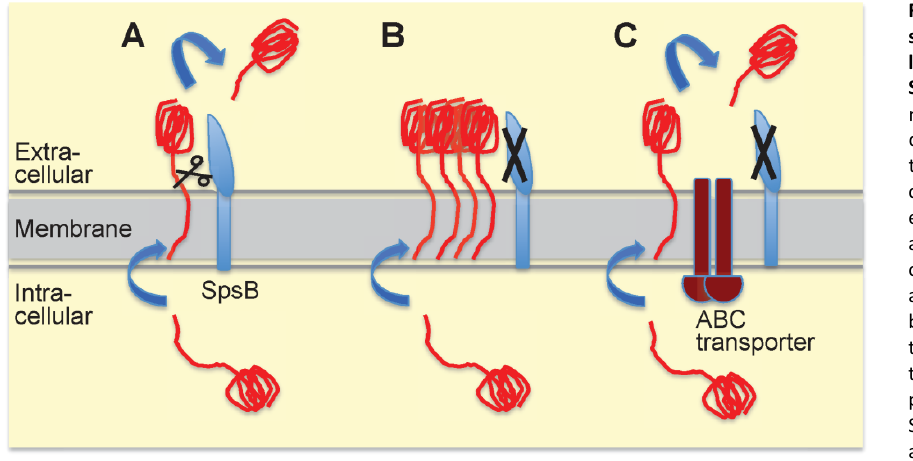
unprocessed proteins, and eventually resulting in cell death. (C) Over-expression of the putative ABC transporter (as in S. aureus with muta- tions in the transcriptional repressor cro/cI ) compensates for a lack of SpsB activity. This transporter mediates SpsB-independent cleavage of a subset of proteins at an alternative cleavage site, leading to their secretion. This alternative secretion pathway is able to restore viabil- ity under conditions of either pharmacological SpsB inhibition (in which case it constitutes the main resistance mechanism) or genetic dis- ruption of SpsB expression. For more details see reference